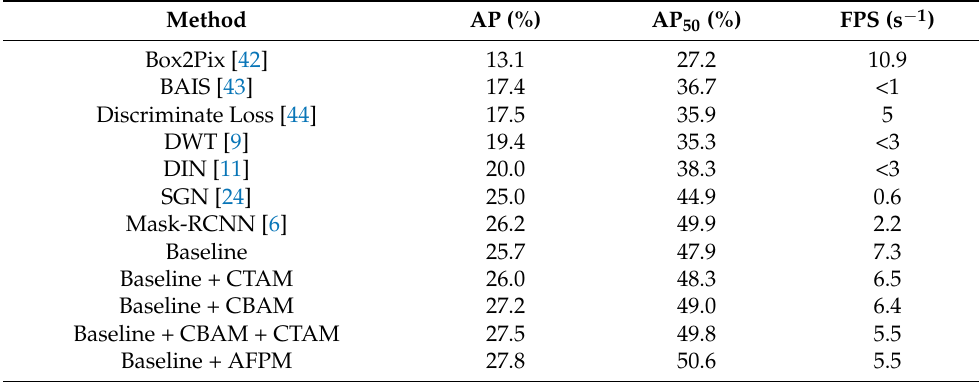
Table 8. Comparison of frames per second (FPS) and AP on the Cityscapes test set